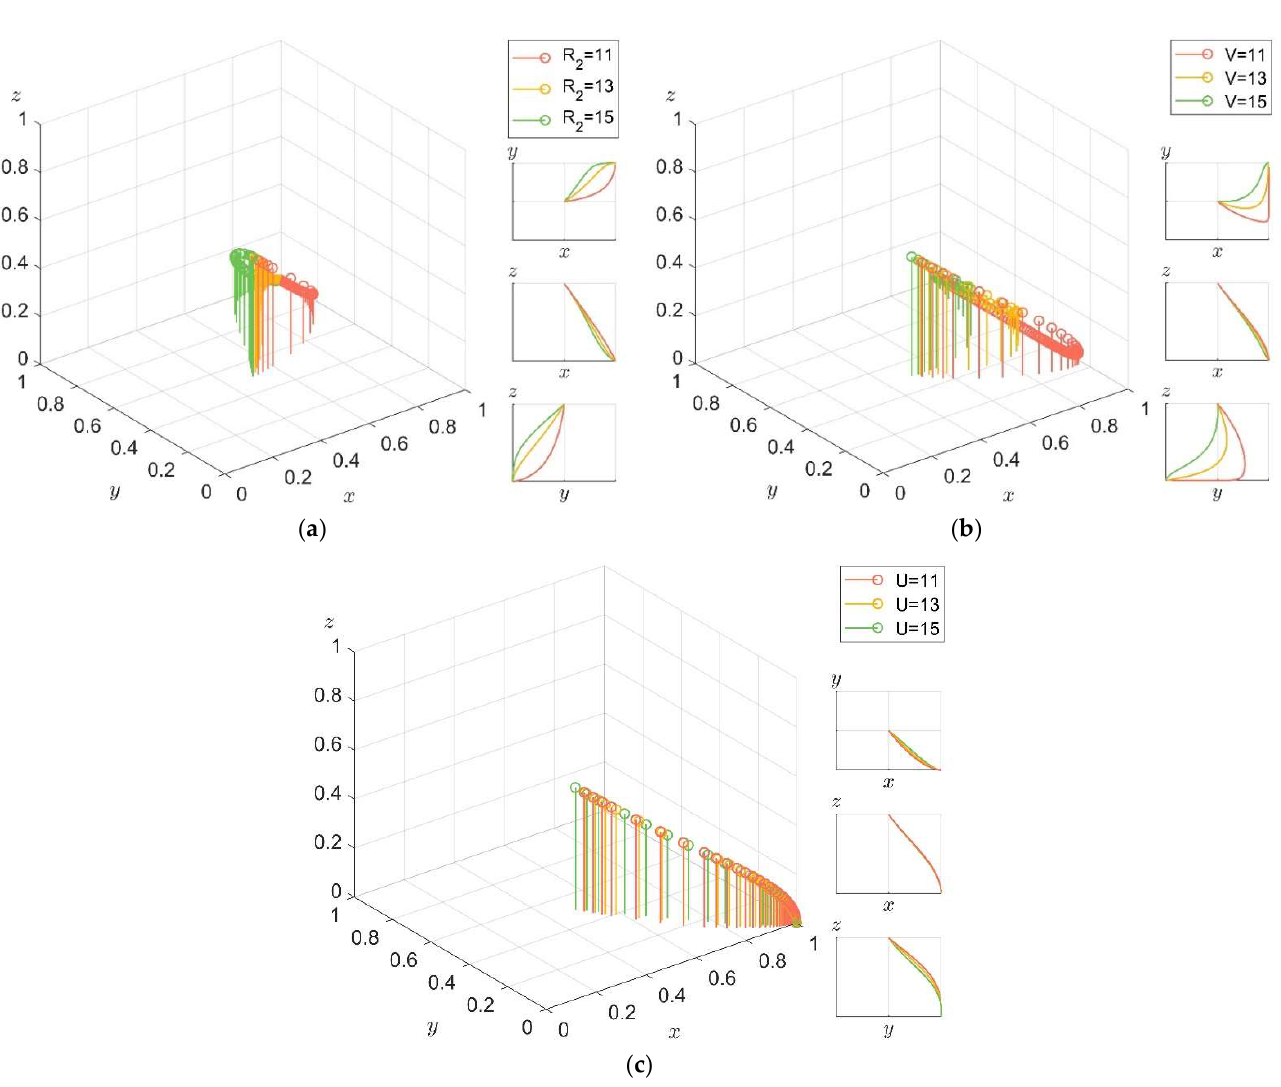
Figure 11. The impact of different income and opportunity costs on enterprise’s low-carbon tech- nology R&D behavior and its evolution path. ( a ) Under different potential benefits. ( b ) Under different market returns. ( c ) Evolution path of the system under different opportunity costs.